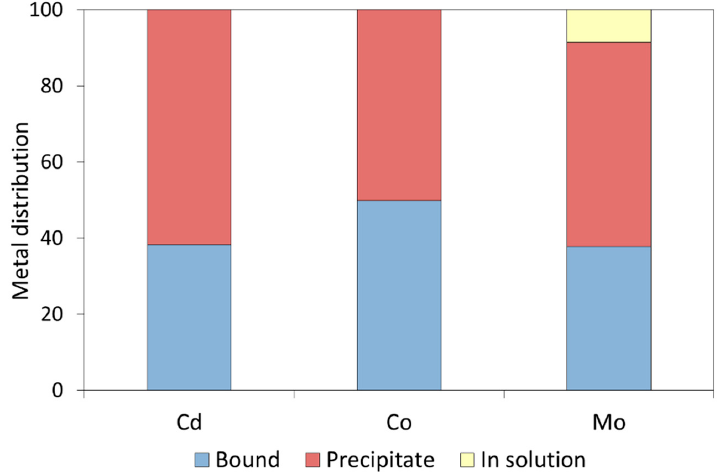
Figure 4. The final partition of each metal after 3